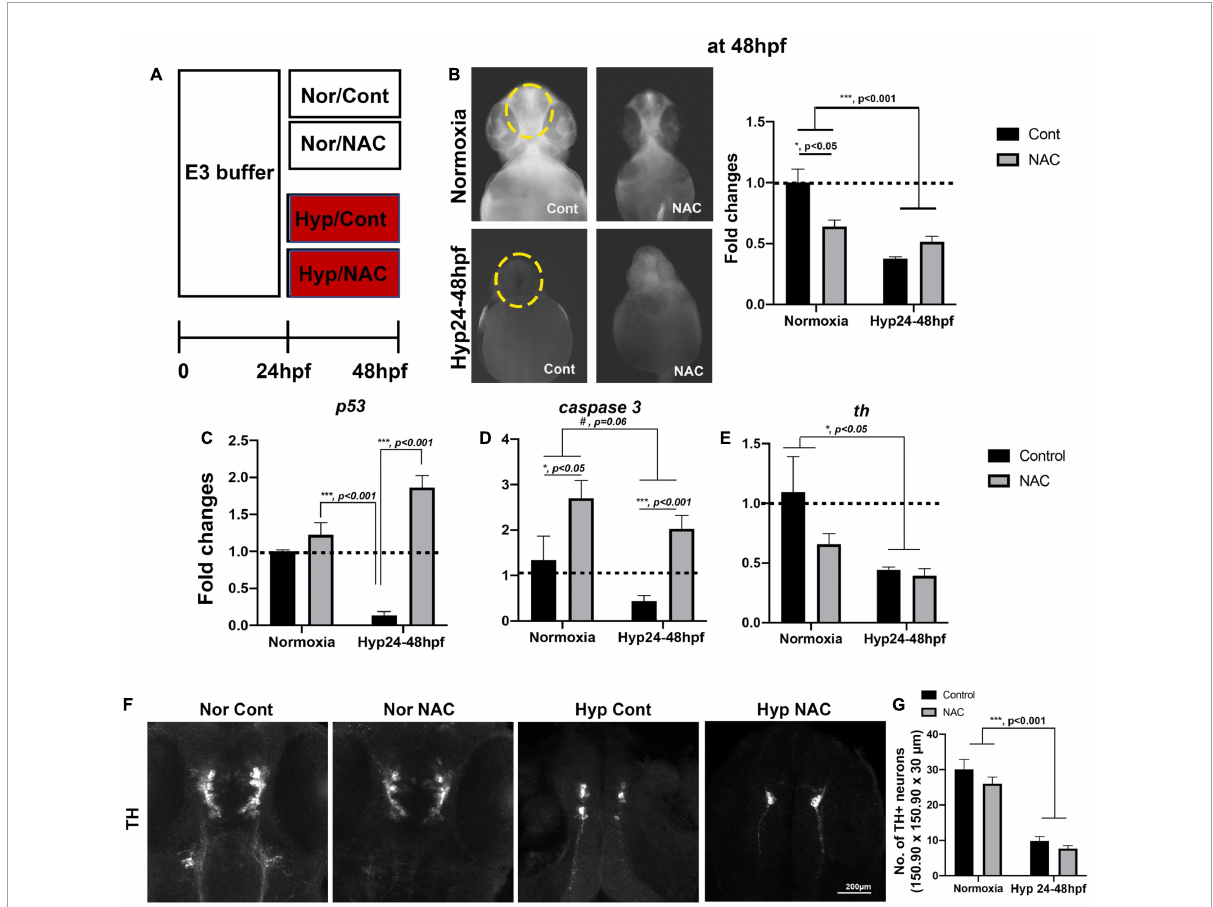
FIGURE4 (A) A schematic diagram for NAC treatment procedures with normoxia (Nor) and hypoxia (Hyp) and the effects of NAC vs. control (Cont) against direct-hypoxic injury at 48 hpf. (B) ROS production/accumulation in zebrafish head at 48 hpf in normoxic zebrafish with control ( n = 6), normoxic zebrafish with NAC ( n = 6), hypoxic zebrafish with control ( n = 3), and hypoxic zebrafish with NAC ( n = 5) analyzed by two-way ANOVA followed by Tukey’s post hoc test and presented as fold change compared to normoxic control. (C–E) Different expression of proapoptotic genes ( p53, caspase9, caspase3 , and bax ) by HR, including normoxic control ( n = 6/group, triplicated) and normoxic NAC ( n = 6/group, triplicated), hypoxic control ( n = 6/group, triplicated), and hypoxic NAC ( n = 6/group, triplicated) analyzed by two-way